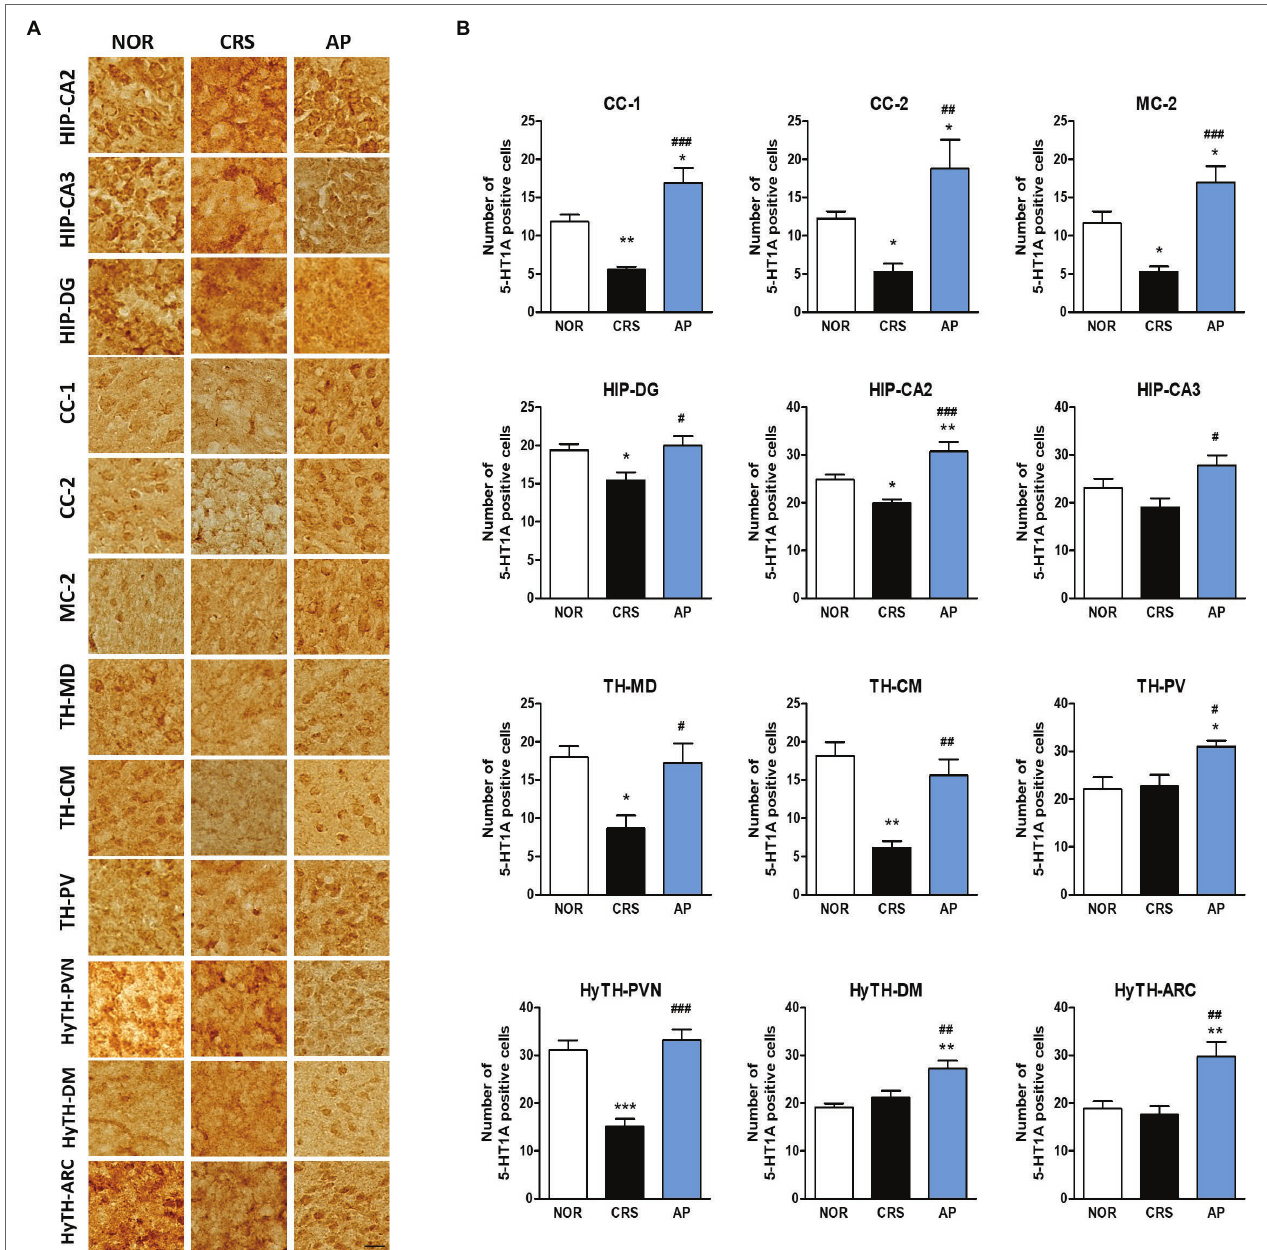
FIGURE 6 | Acupuncture treatment at AP (KI10·LR8·LU8·LR4) changes 5-HT1A receptor expression in the cortex, hippocampus, thalamus, and hypothalamus. (A,B) Acupuncture treatment at AP (KI10·LR8·LU8·LR4) significantly increased 5-HT1A expression in the cortex, hippocampus, thalamus, and hypothalamus as compared to the CRS group. NOR, normal; AP, CRS and acupuncture treatment at KI10·LR8·LU8·LR4; NP, CRS and acupuncture treatment at non-acupoints on the hips. * p < 0.05, ** p < 0.01, *** p < 0.001 vs. NOR. # p < 0.05, ## p < 0.01, ### p < 0.001 vs. CRS. One-way ANOVA followed by the Newman-Keuls test. Error bars indicate